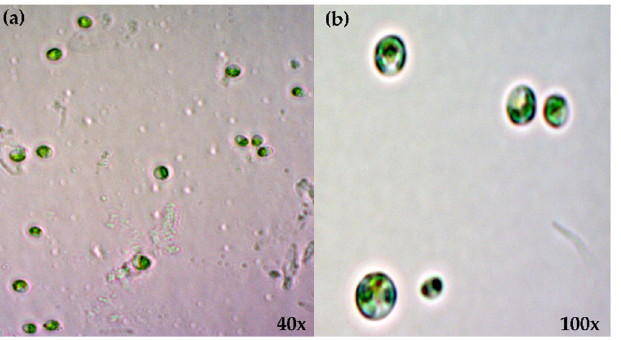
Figure 1. Representative microscopic image of Picochlorum sp. BDUG100241 ( a ) 40× and ( b ) 100× magnification under the photoautotrophic condition. magnification under the photoautotrophic